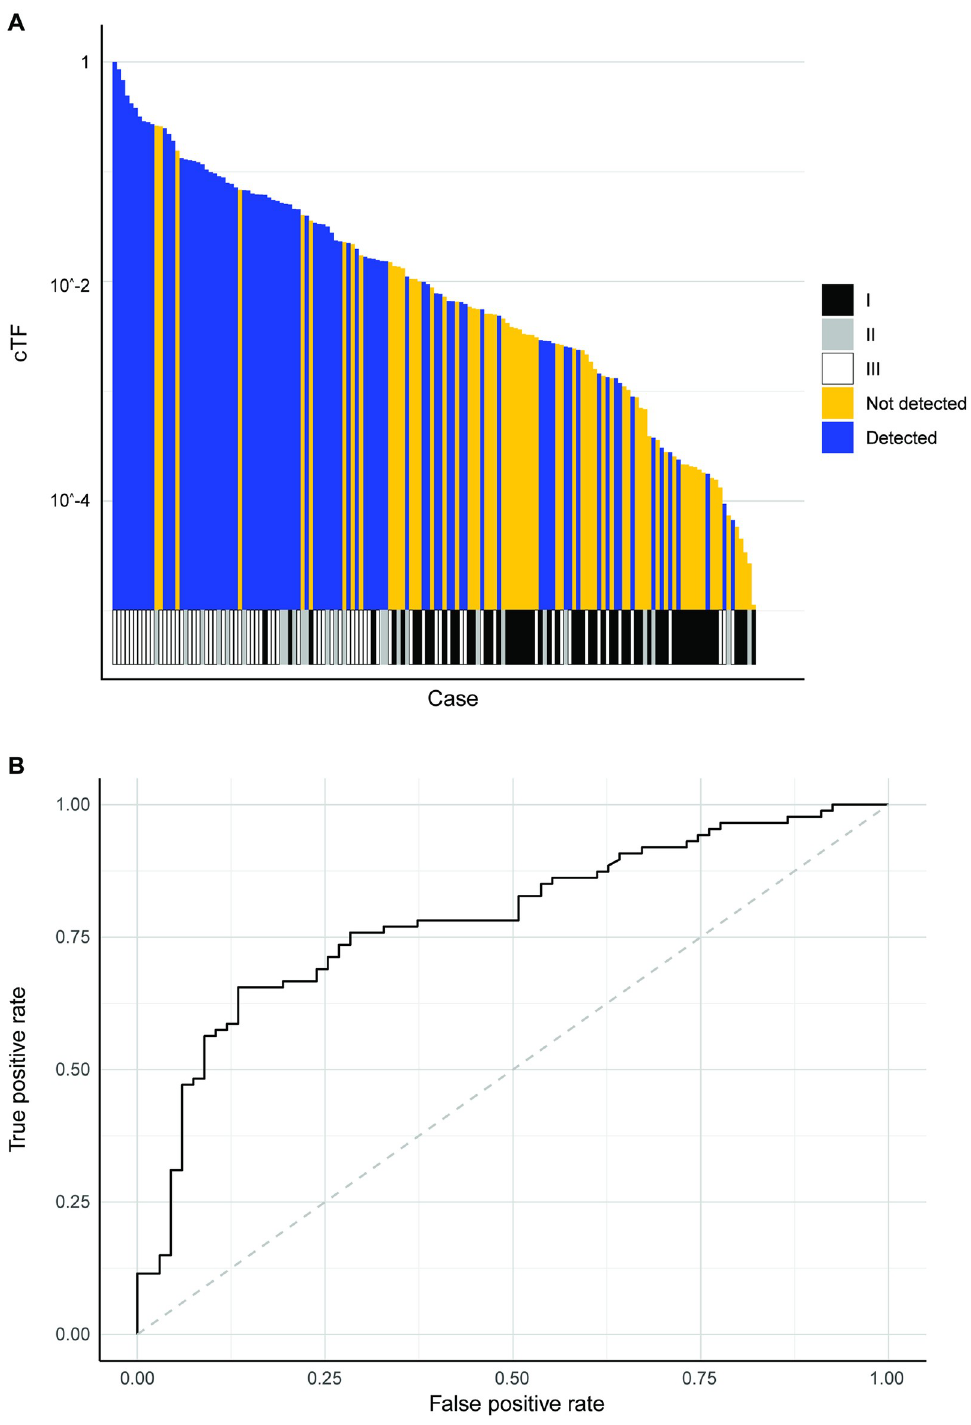
Fig 9. Lung cancer model validation. (A) Detection by TM assay for lung cancer samples sorted by ELG. (B) ROC to predict lung cancer detection by TM assay using ELG. cTF: Circulating tumor fraction, ELG: Excessive lesion glycolysis, ROC: Receiver operating characteristic curve, TM: Targeted methylation.